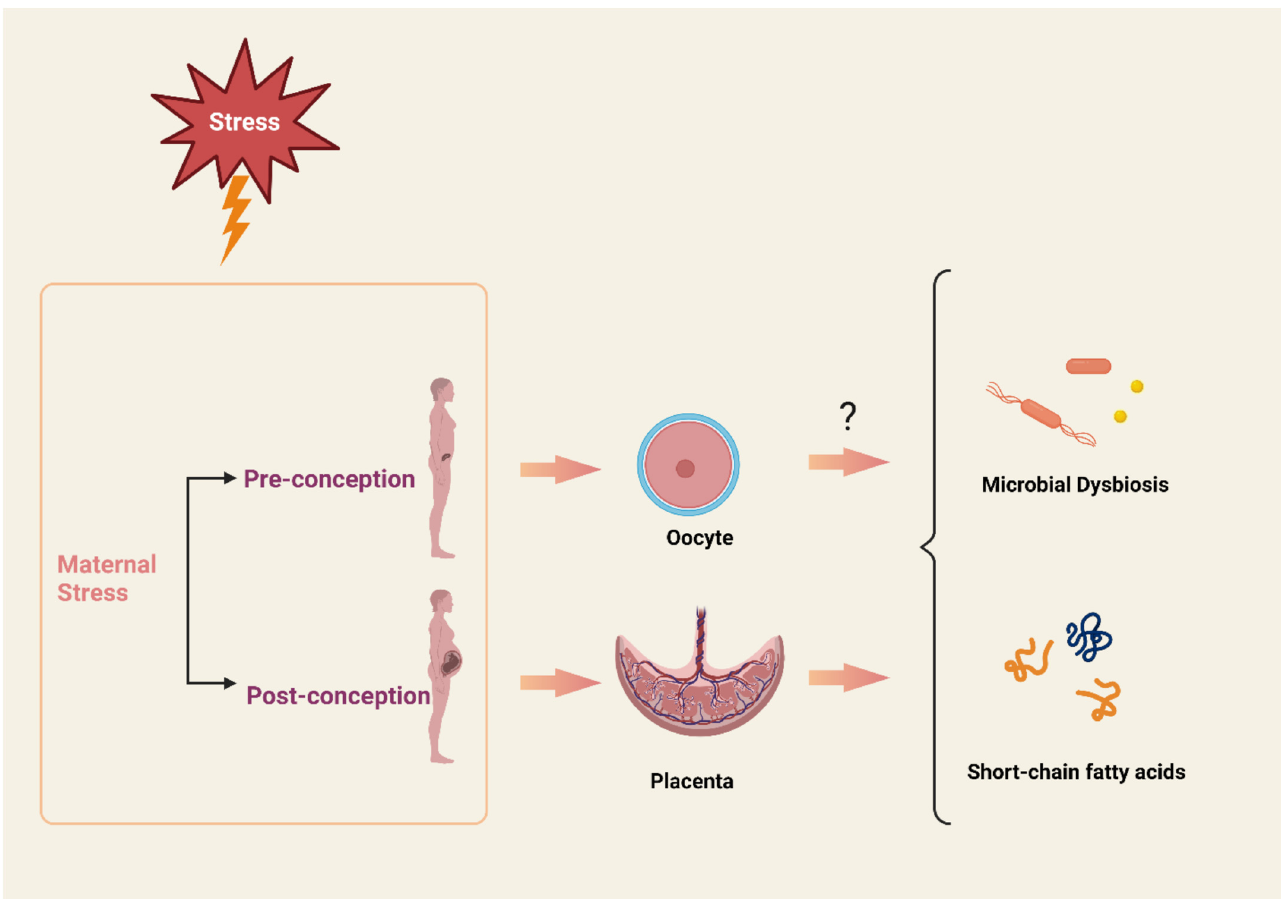
Figure 1. Cross-generational transmission of parental stress can impact offspring microbiome and metabolite production. Maternal stress during pre-conception or post-conception modulates the oocyte and placenta, respectively, leading to microbial dysbiosis. It is unclear how maternal precon- ception stress via the oocyte can influence the microbiome. Cartoon was created with BioRen- der.com.